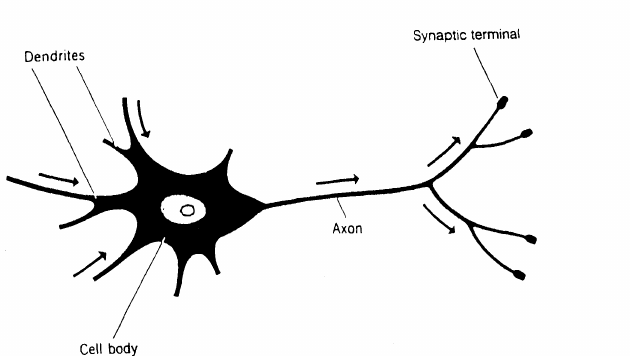
FIGURE 3 A schematic representation of a neuron which consists of cell body (soma), dendrites where the neuron received information from the synaptic terminal, and axon where the action potential is transmitted to the synaptic term- inal, and synapse where the neurotransmitter is